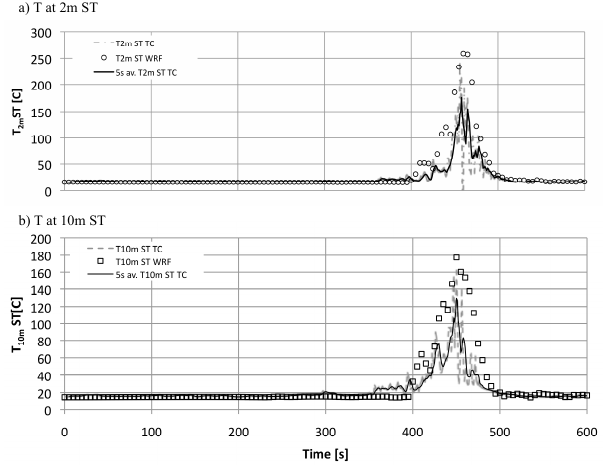
Fig. 6. Time series of the thermocouple air temperatures at the lo- cation of the short tower (ST) at (a) 2m and (b) 10m. Gray dashed lines show 1Hz measurements, black solid lines 5s averaged val- ues, and symbols (open circles and squares) model